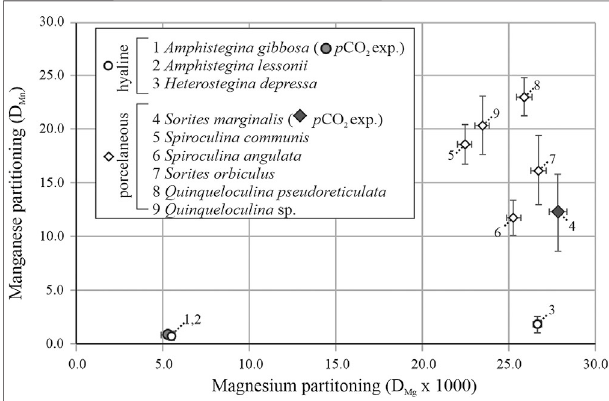
FIGURE 4 | Overview of the average partitioning of Mn (D Mn ) as a function of D Mg × 10 3 for foraminiferal species studied here, from both the controlled p CO 2 experiment (average value, closed symbols) and the Indo- Paci fi c coral reef aquarium (open symbols). Hyaline species and porcelaneous species are indicated with circles and diamond respectively. Error bars indicate SD and numbers indicate species.